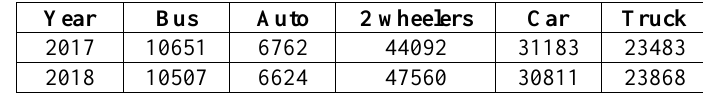
Table 10: Road death based on type of vehicle.